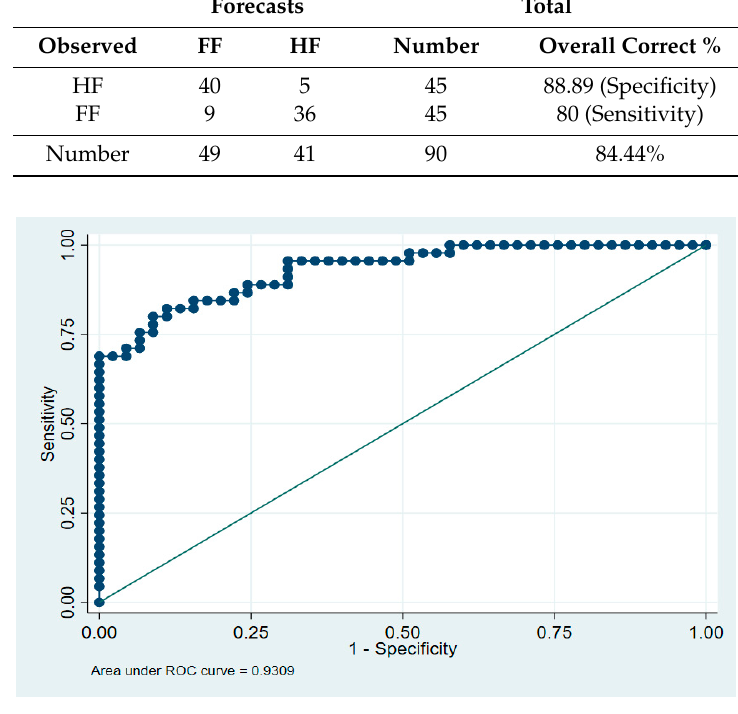
Figure 3. The ROC curve of the model one year before failure. Table 9. Classification of failing firms (FF) and healthy firms (HF) one year earlier.